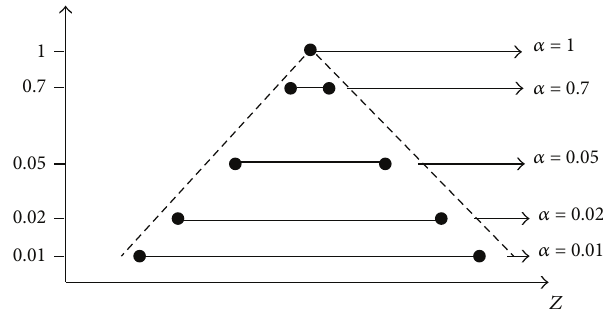
Figure 1: Fuzzy test